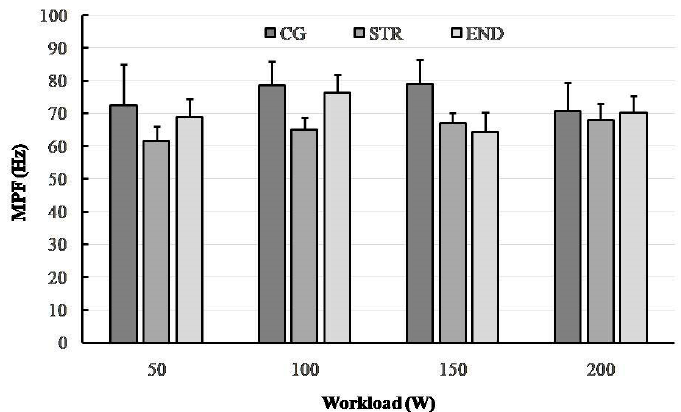
Figure 1. The changes in median frequency (MF) in the research groups (END—triathlon; STR—bodybuilder; CG—recreationally active) during progressive cycling exercise test at subse- quent workloads; point and whiskers—mean ± SD.